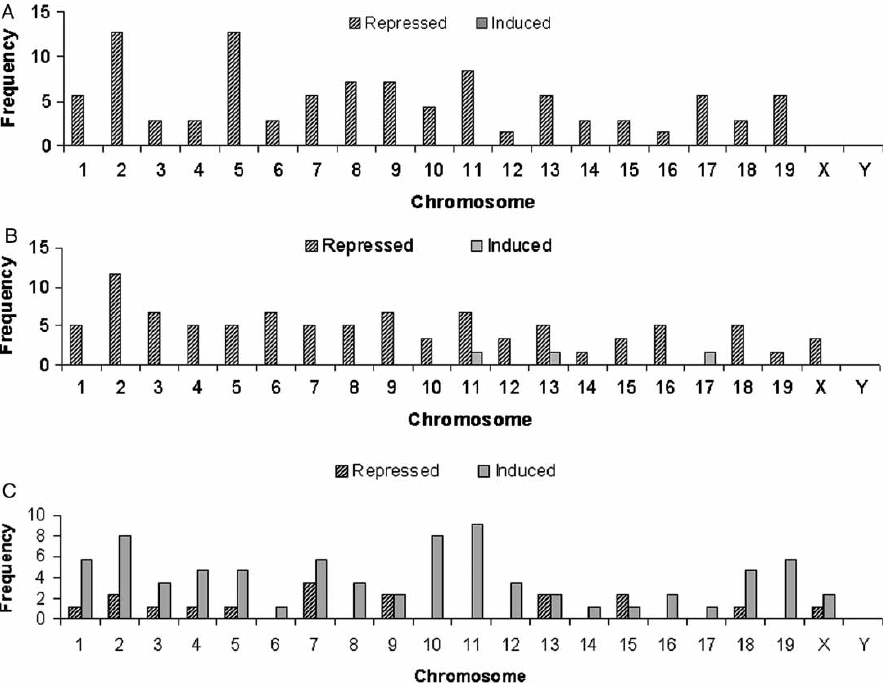
Figure 3. Chromosomal distribution of the repressed and induced genes in the fetal thymus during the emergence of TRBV8.1 recombination among inbred mouse strains. 3A ¼ Balb-c, 3B ¼ C57Bl/6, 3C ¼ (Balb-c £ C57Bl/6)F 1